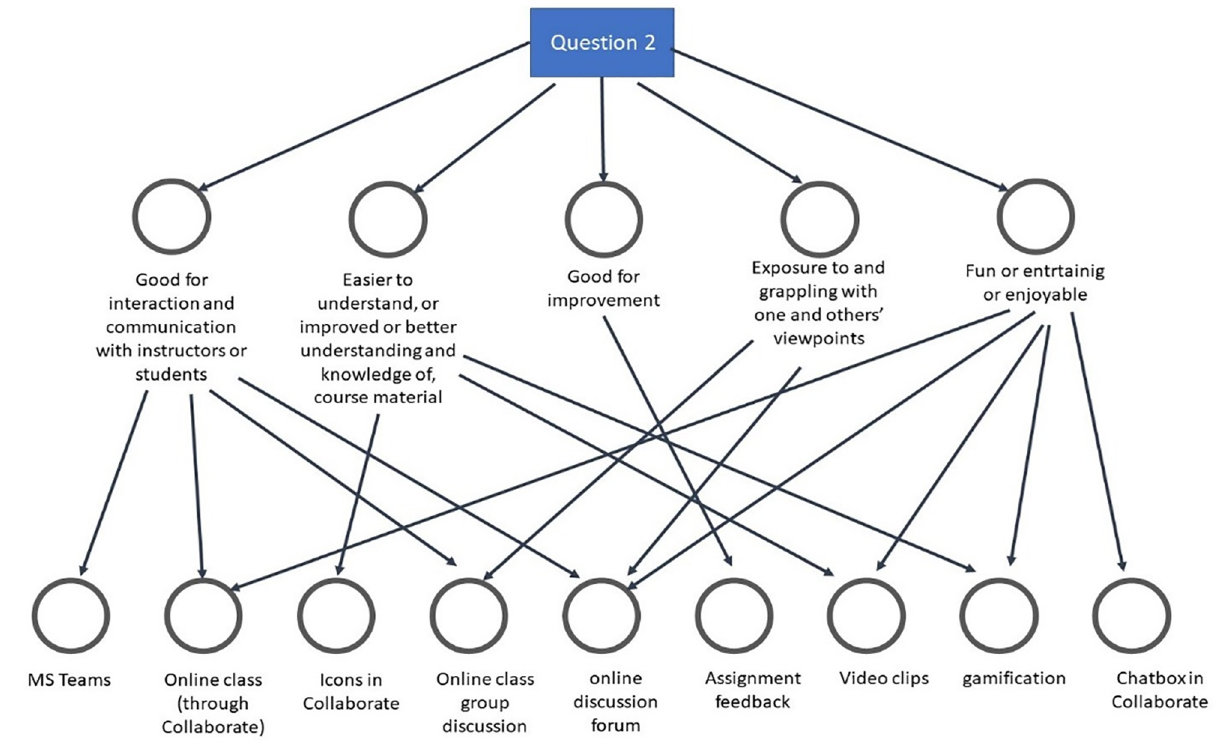
Fig 3. Reasons for students’ choices of social computing software and tools used in the